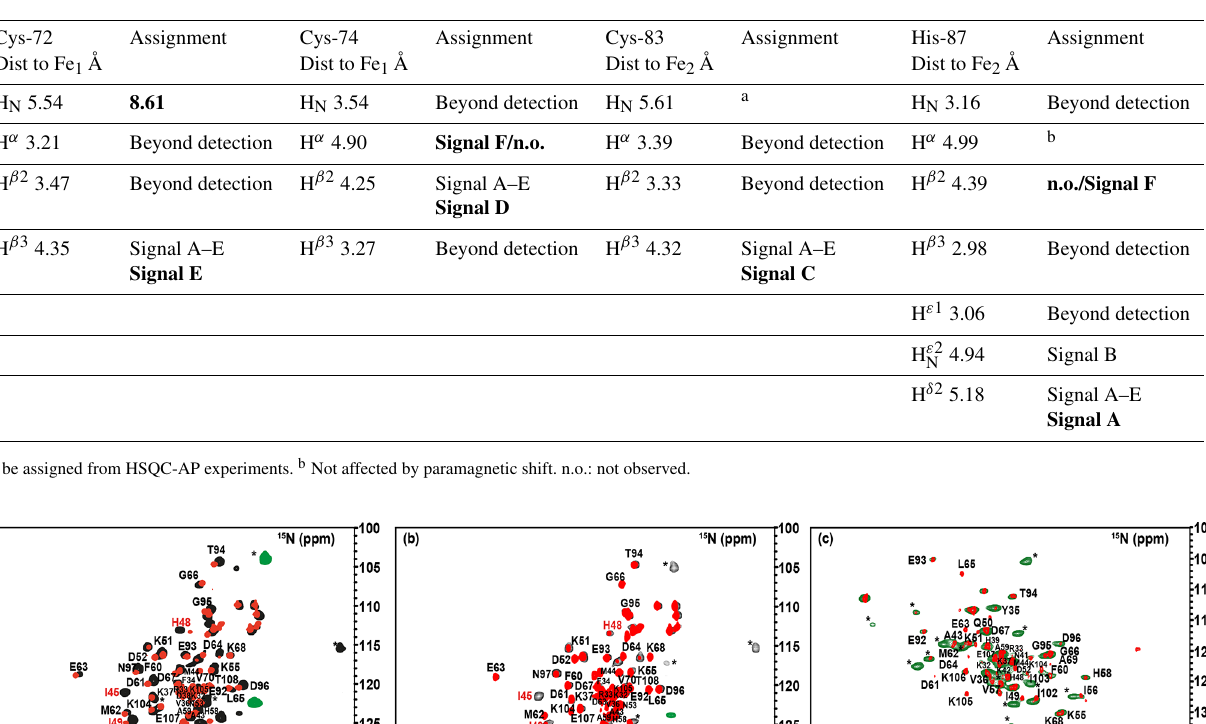
Table 2. Distance-based proposed assignment of the paramagnetic NMR spectrum of oxidized MitoNEET. In the assignment columns, bold text indicates the proposed assignment according to 1D NOE experiments.